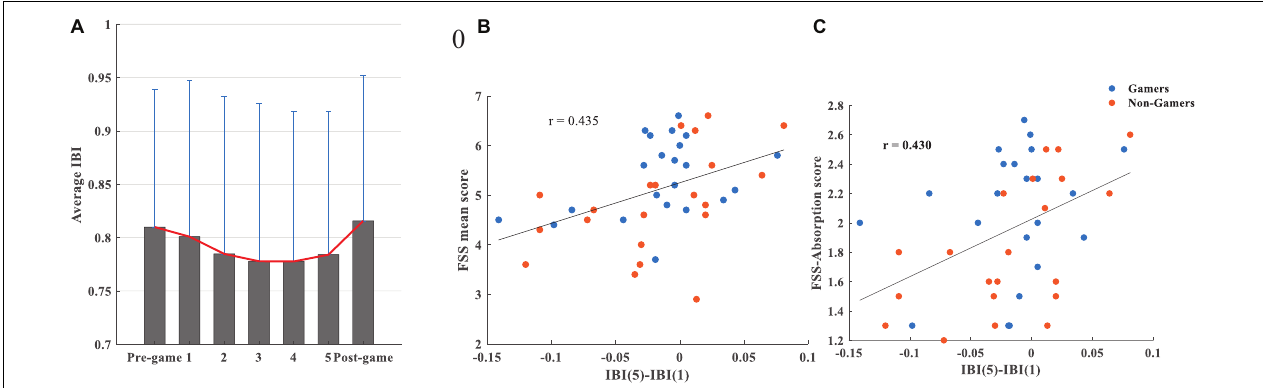
FIGURE 5 | (A) The average IBI and its standard deviation during the pre-game, 5-min intervals while playing the game (1, 2, 3, 4, 5), and the post-game conditions, (B) association between the difference in the IBI during the last and the first 5 min of gameplay and the FSS mean score, (C) association between the difference in the IBI during the last and the first 5 min of the gameplay and the FSS-absorption